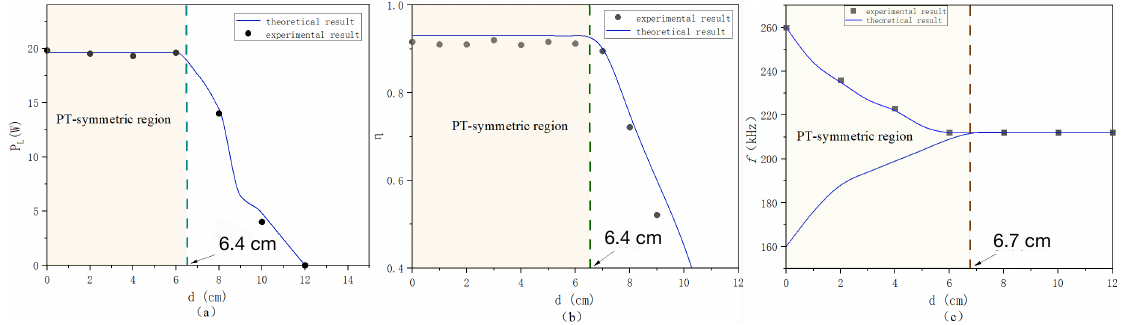
Figure 15. The curves of transmission performance versus transmission distance for case 1: ( a ) output power; ( b ) efficiency; ( c ) operating